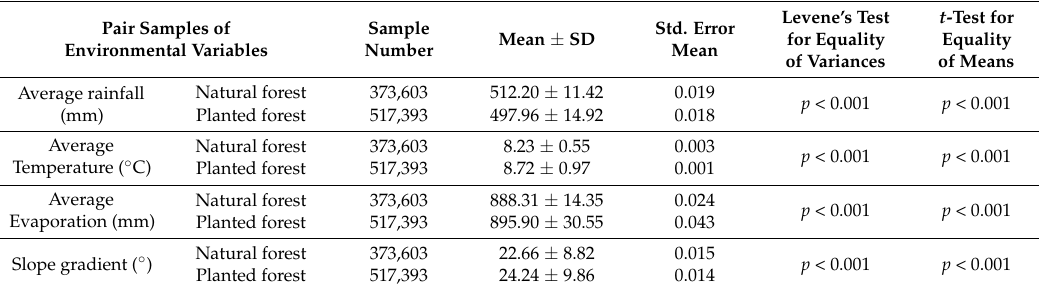
Table 1. Statistical tests for equality of variances (Levene’s Test) and means ( t -test) in environmental variables between natural and mismatched planted forest.